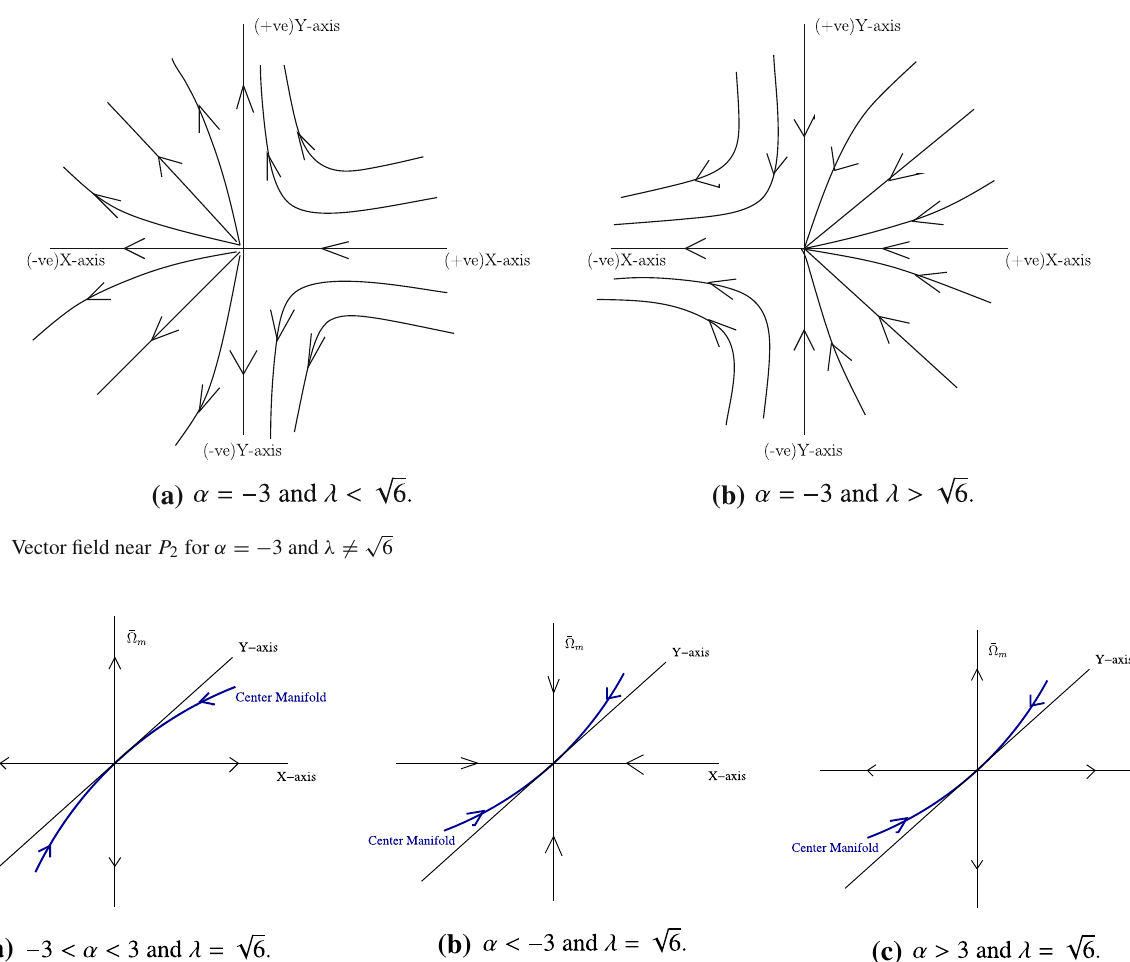
√ 6. All center manifolds (blue curves) lie on